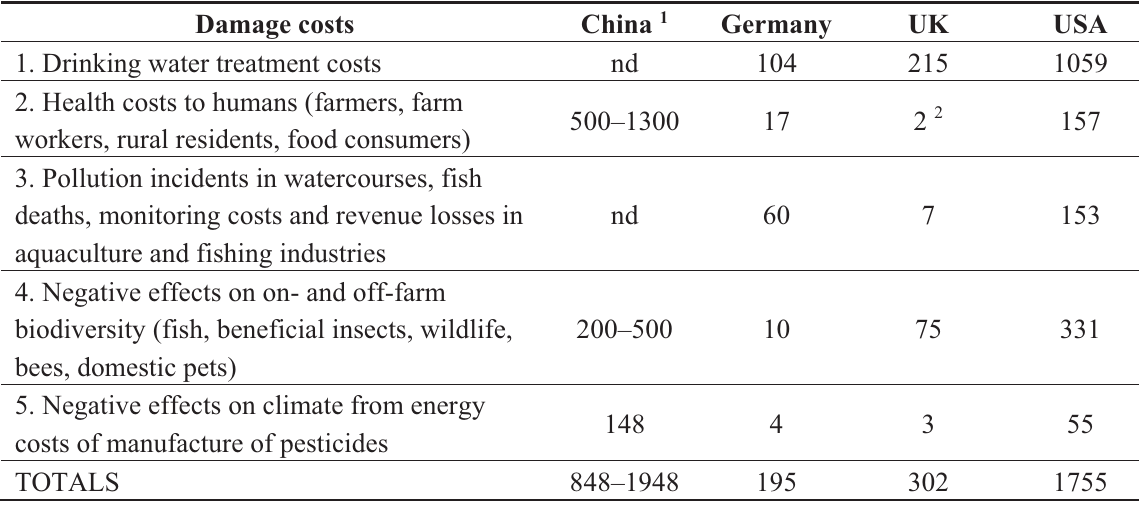
Table 2. Cost category framework for assessing full costs of pesticide use (million US $ per year,